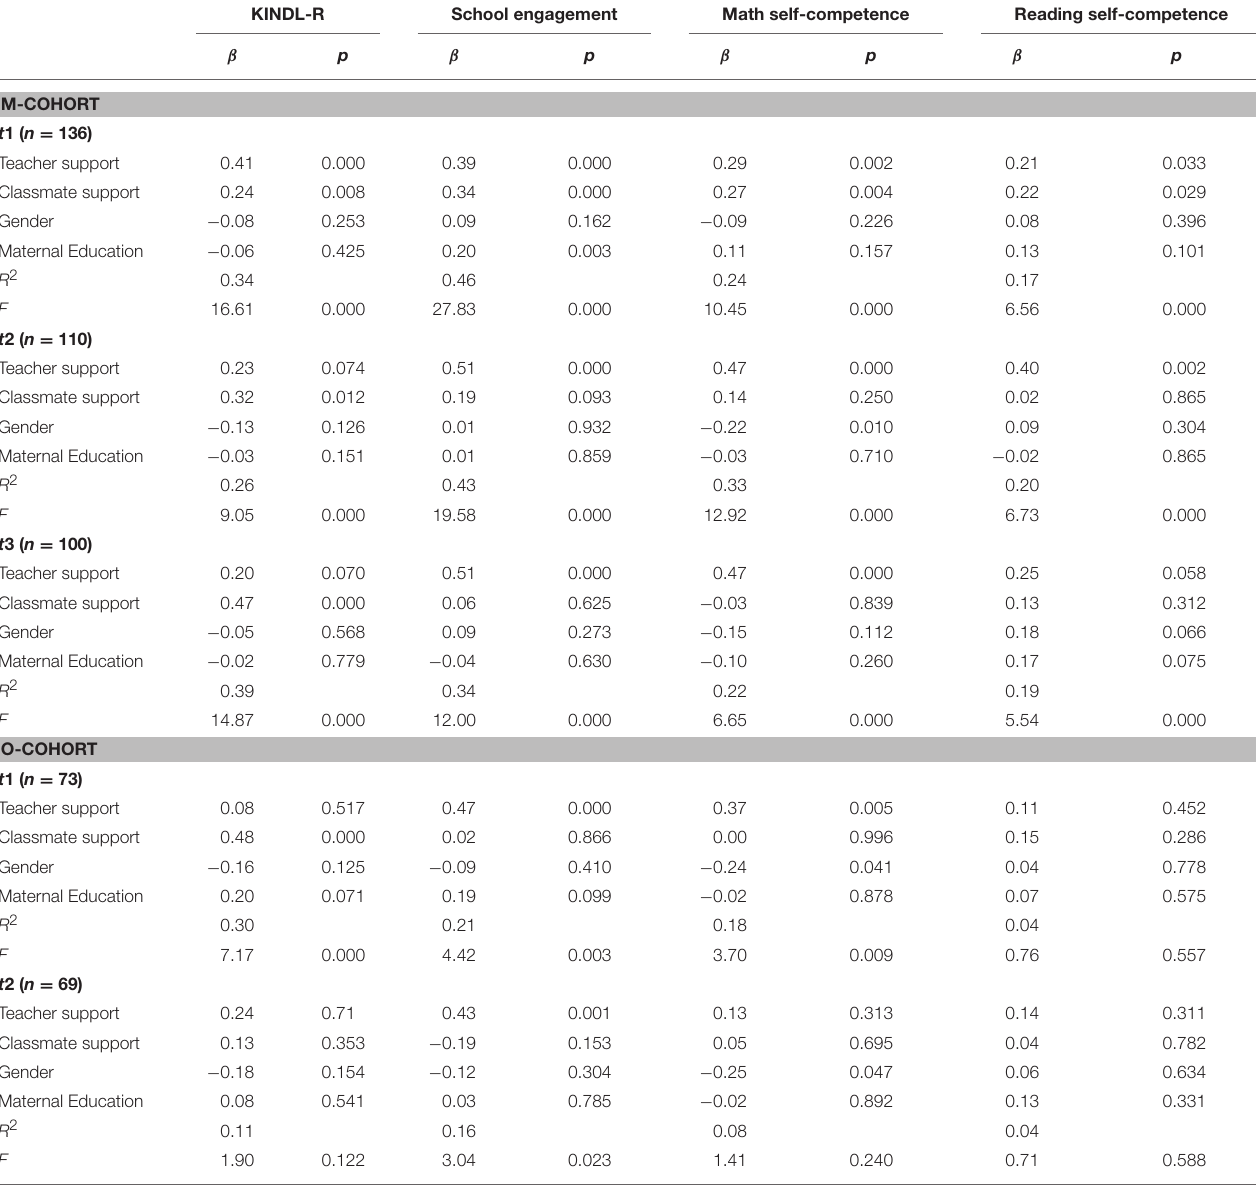
TABLE 3 | Results of multivariate regression analyses predicting students’ HRQoL and school outcomes. KINDL-R School engagement Math self-competence Reading